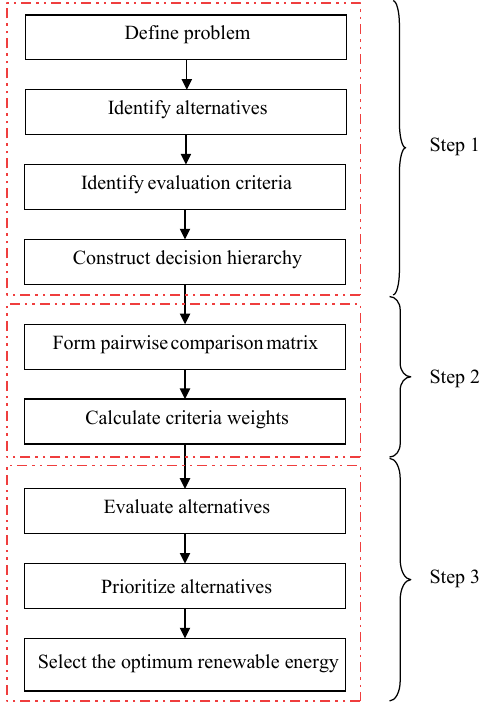
Fig. 1. Schematic diagram of the proposed